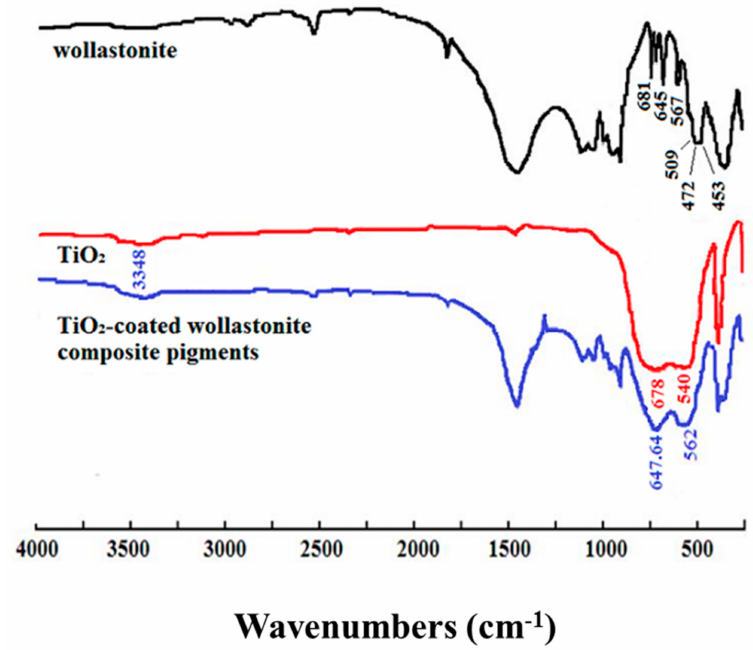
Figure 6. Fourier-Transform Infrared (FTIR) spectra of wollastonite particles, TiO 2 particles and the composite particles.